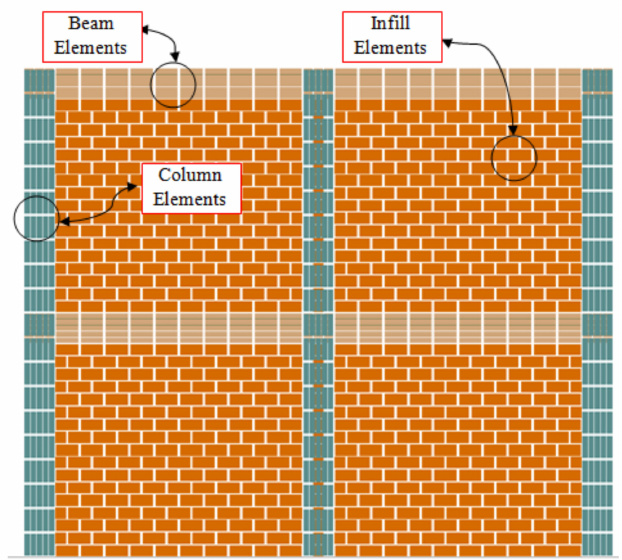
Figure 9. Schematic representation of Continuum applied element model of H-building